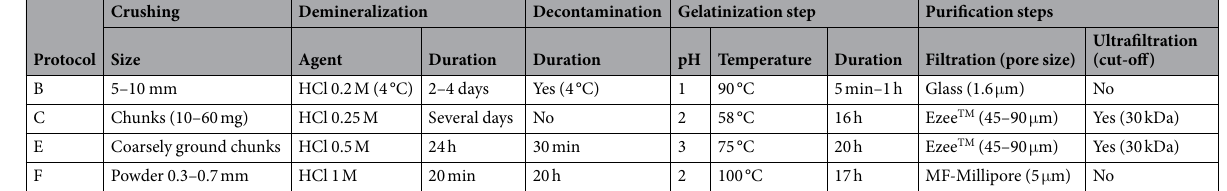
Table 1. Collagen extraction protocols: summary of the different steps. Protocols were designated in agreement with ref.